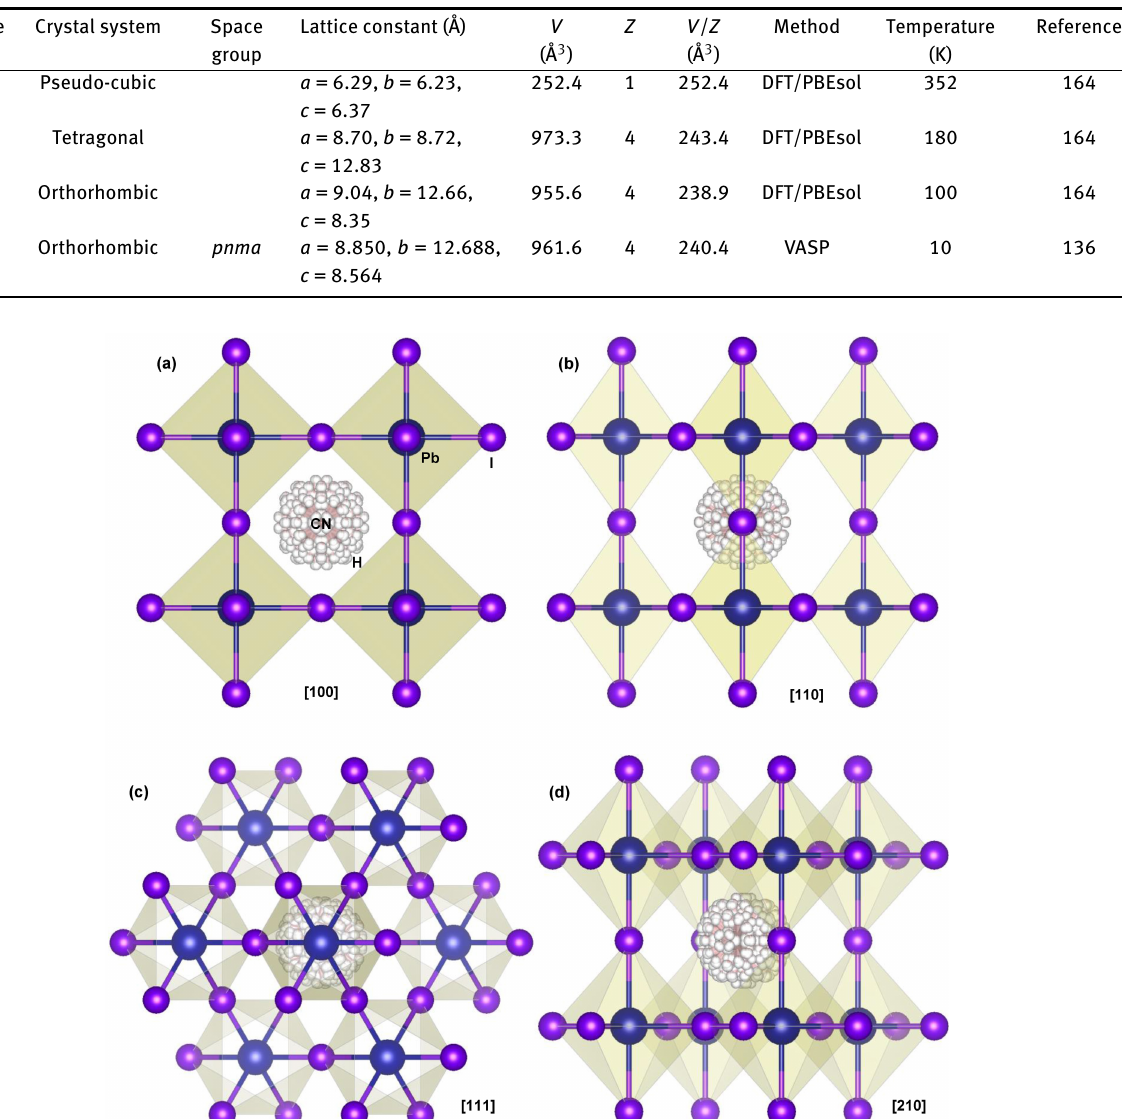
Table 8: Calculated crystal parameters of CH 3 NH 3 PbI 3 .